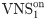
Example of acute cardiac effects provoked by two different sets of VNS parameters.Sequence VNS1on was applied with parameters S1 = [0.8 mA, 2 pulses, 0.05 ms, 21.3 Hz, 125 ms], while sequence VNS2on with S2 = [0.4 mA, 2 pulses, 0.2 ms, 21.3 Hz, 125 ms].